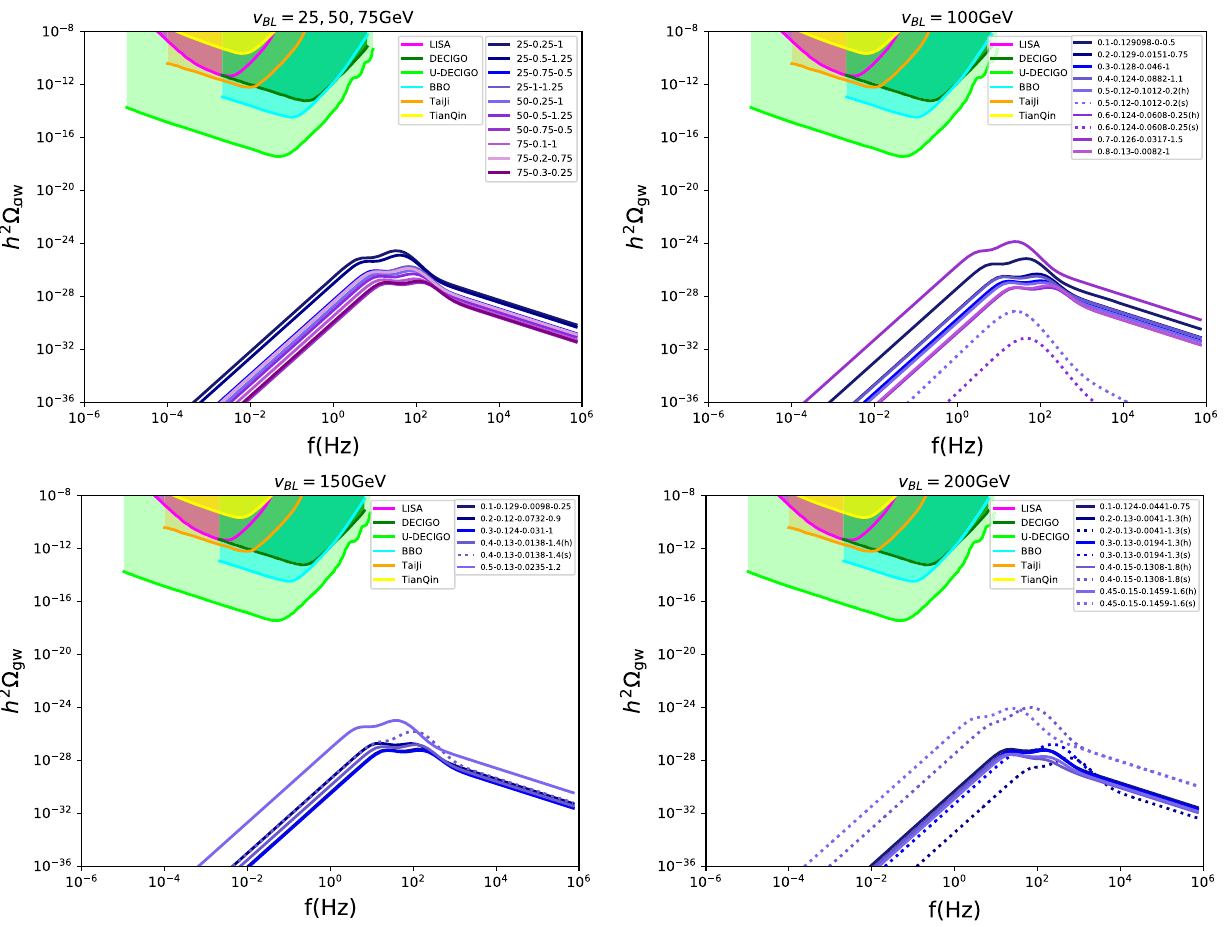
Fig. 4 Gravitational wave signals from the model parameters with benchmark scales 100, 150, and 200 GeV, we take another notation v < v = 246 GeV, compared with the detectability of future ‘ λ s − λ h − λ sh − g ’ in the plots. The solid lines refer to GWs from BL e w spatial interferometers. For the benchmark scales v BL = 25 , 50, hybrid first-order PTs, the dotted lines refer to s -direction PTs. For parameters that lead to first-order PTs twice, we have used suffixes ( h ) and 75 GeV, we use the simplified string notation ‘ v BL − λ s − g ’ /( 2 × v 2 ) , and λ = 0. For the or ( s ) to make it since we have fixed λ h = m 2 sh e w H , SM